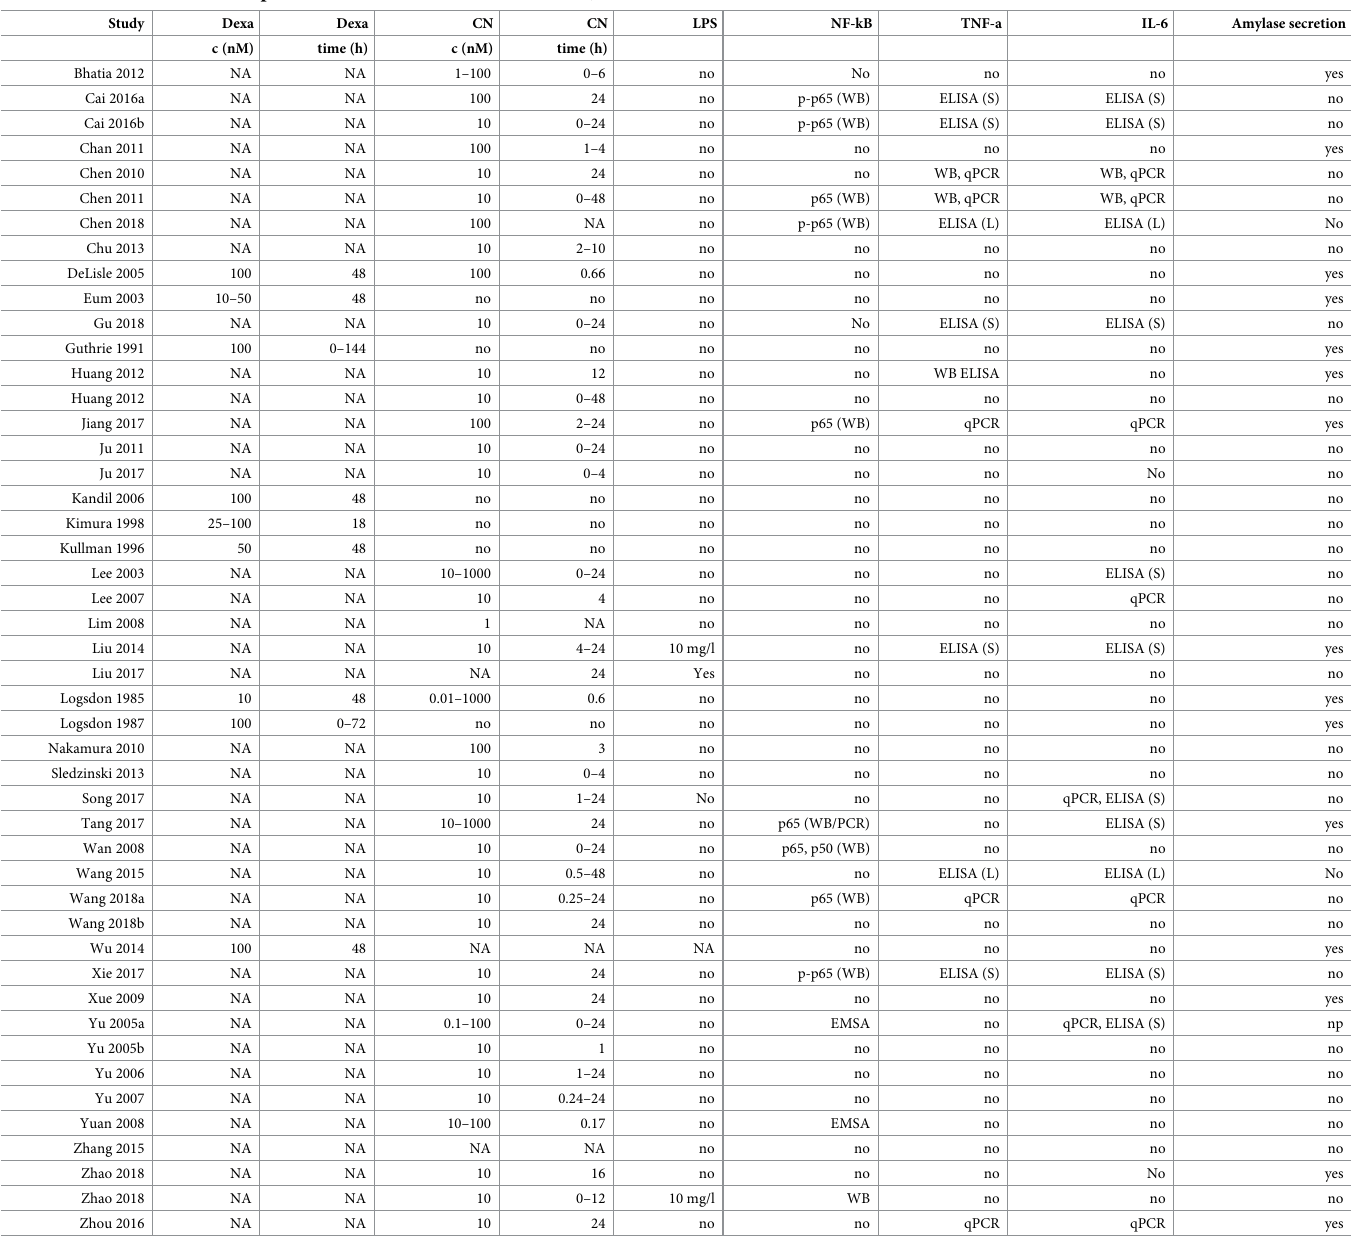
Table 1. Published studies and protocols of cerulein treatment in AR42J cells. Study